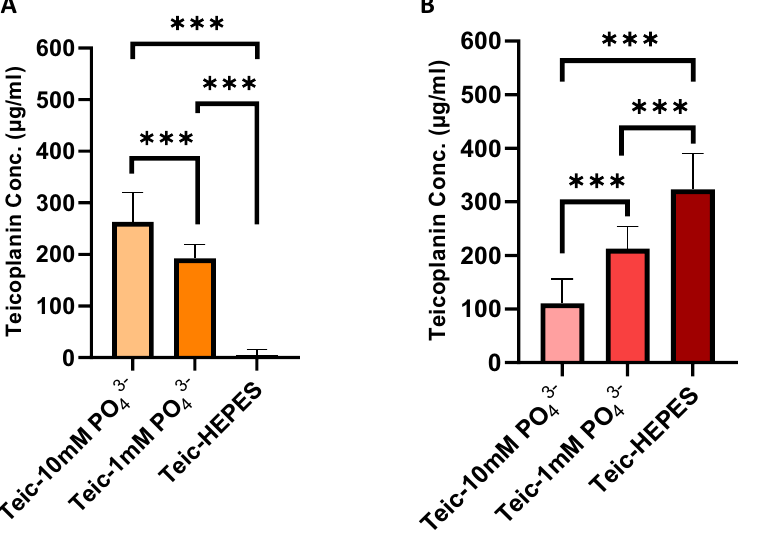
Figure 6. Influence of phosphate on Teic adsorption to TiO 2 . ( A ) TiO 2 powder (50 mg) were exposed to 500 µg/ml Teic in PBS (500 µl) where the phosphate concentration was either 1 mM or 10 mM and samples left to incubate at room temperature for 30 min. Teic (500 µg/ml) reconstituted in 50 mM HEPES (pH 7.4) served as a positive control for TiO 2 binding. After incubation, 25 µl aliquots of the supernatant were combined to 500 µl BCA reagent and incubated for 30 min at 60 °C. Once incubated, 100 µ aliquots were transferred to a 96-well plate and measured at 540 nm using a microplate reader. It is evident that phosphate reduces the extent of Teic binding to the metal oxide (*** p < 0.0001). ( B ) To confirm Teic attachment to TiO 2 , the supernatant was decanted, and the powder samples were washed once by centrifugation (11,300 × g) and resuspended in 500 µl buffer. A 25 µl sample of each powder suspension was added to 500 µl of BCA reagent and incubated for 30 min at 60 °C. Once incubated, samples were centrifuged and 100 µl of the supernatant were transferred to a 96-well plate and measured in the same manner as above. Significantly less Teic (*** p < 0.0001) is present on TiO 2 exposed to phosphate. All data (mean ± SD; N = 20) represent pooled quadruplicate runs from 5 independent experiments.